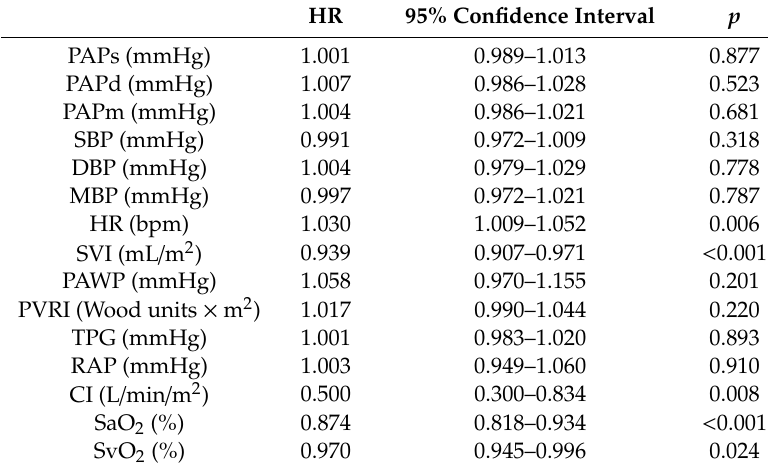
Table 5. Risk factors of death or lung transplantations in five-year follow-up. Univariable Cox regression analysis of hemodynamic initial parameters.